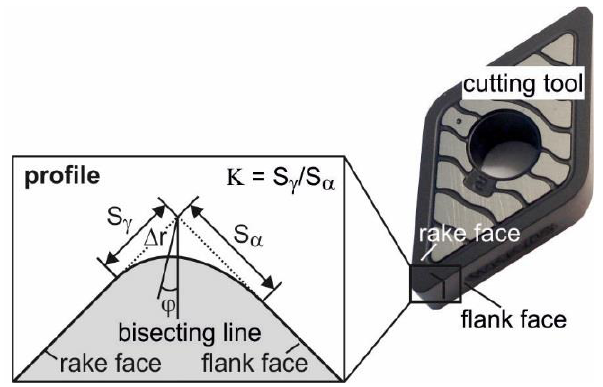
Figure 2. Characterization of the cutting edge microgeometry.